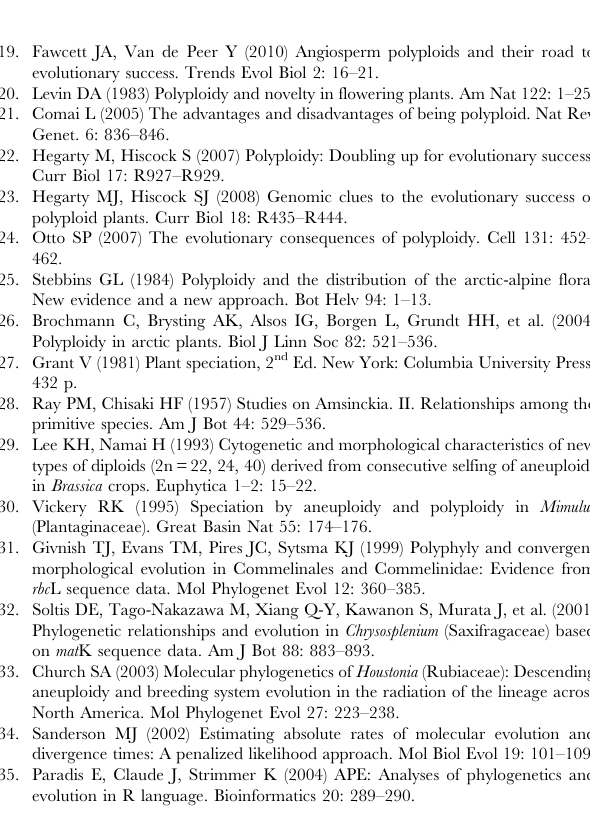
Supporting Information S2 Table S1. Parameters of the best supported model inferred for each group with ChromEvol. Table S2. Species, diploid chromosome number ( 2n ) and genome size (2C, pg) for Cistaceae. Table S3. Species, diploid chromosome number ( 2n ) and genome size (2C, pg) for Antirrhineae. Table S4. Species, diploid chromosome number ( 2n ) and genome size (2C, pg) for Saxifraga sect. Saxigraga . Table S5. Species, diploid chromosome number ( 2n ) and genome size (2C, pg) for Orchidinae . Table S6. Species, diploid chromosome number ( 2n ) and genome size (2C, pg) for Resedaceae. Table S7. Species, diploid chromosome number ( 2n ) and genome size (2C, pg) for Passiflora .